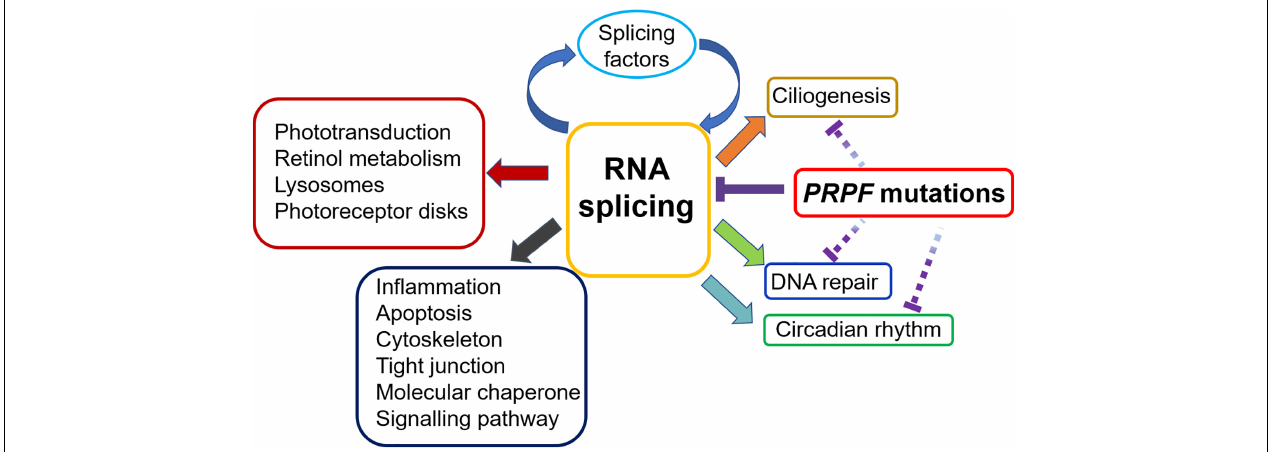
FIGURE 3 | Impacts of PRPF mutations on various biological processes in the retina. RP-related PRPF mutations primarily result in disrupted spliceosome assembly and defective RNA splicing, leading to subsequent alteration of splicing profile. Many of the affected genes are involved in important retinal functions, including phototransduction, retinol metabolism and photoreceptor disk, etc. More mis-spliced genes cluster in general biological processes, such as inflammation, apoptosis cytoskeleton, signalling pathway, etc. Noteworthy, splicing factors are enriched in the top category of mis-spliced genes affected by PRPF mutations, indicating a feedback loop that deteriorates the RNA splicing defect in retina. Furthermore, emerging evidence suggests that PRPF mutations may contribute to RP development via mechanisms beyond RNA splicing. The interrupted lines indicate likely direct effects of PRPF mutations on ciliogenesis, circadian rhythm and DNA